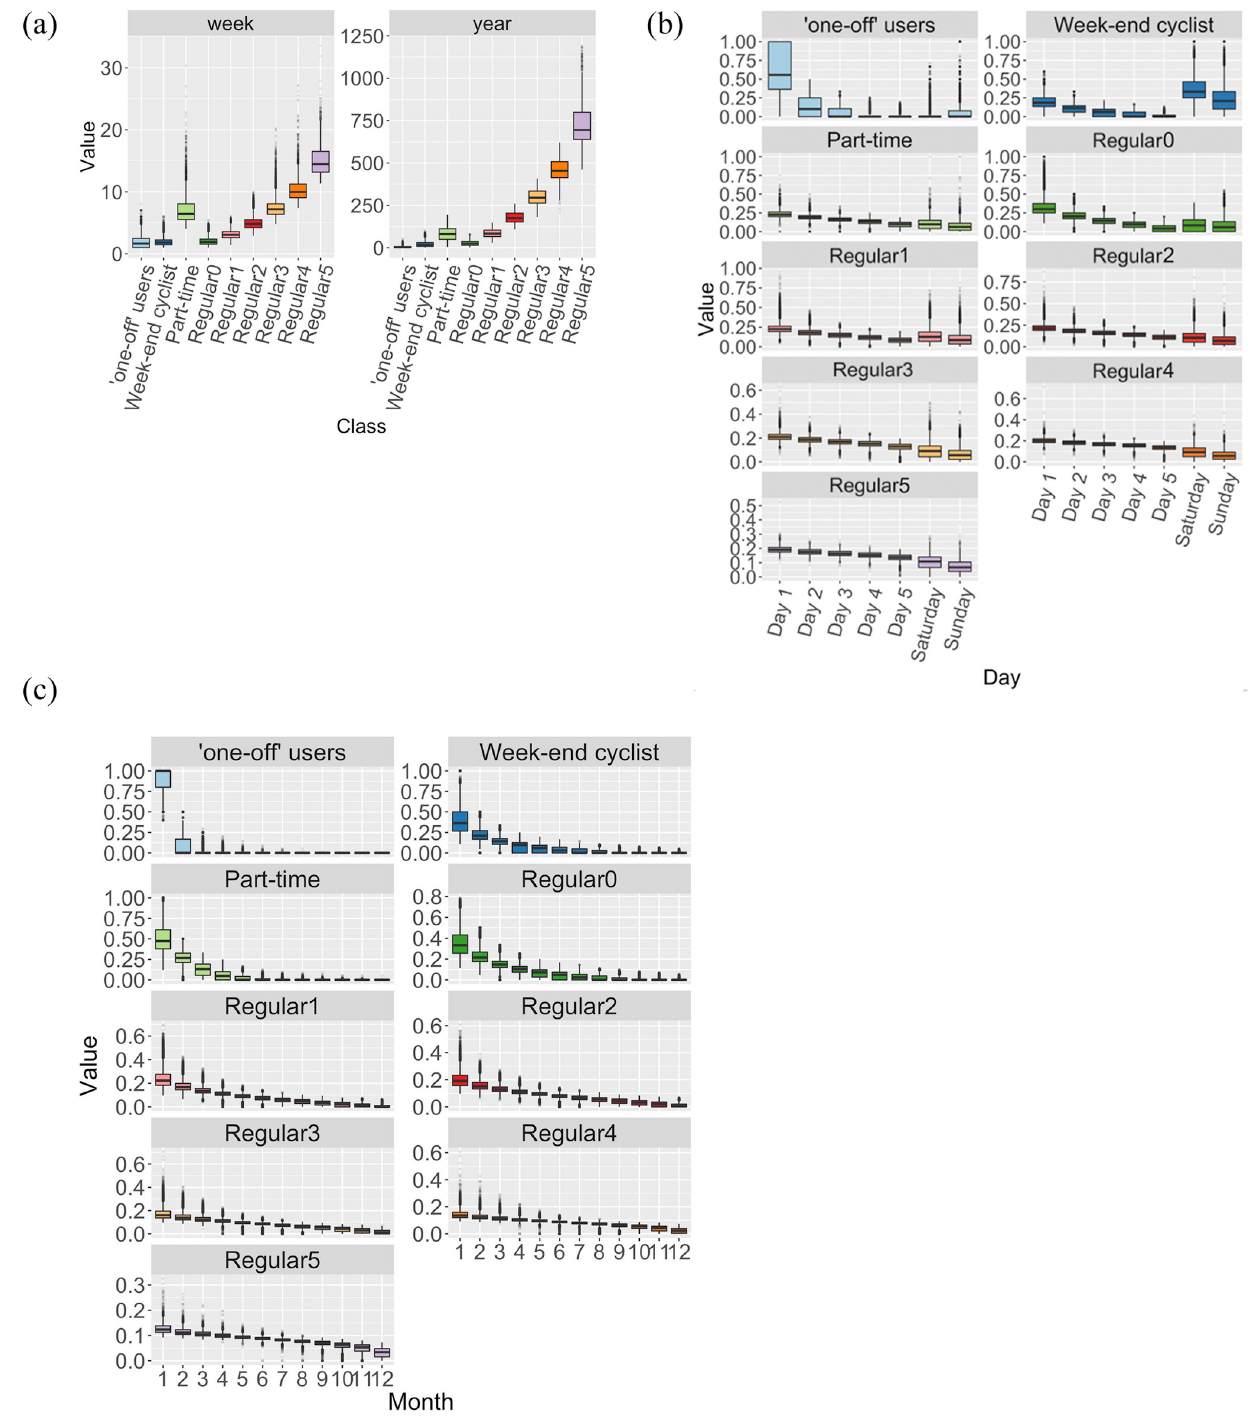
Fig 5. Boxplots of the behavioral patterns at different time scales of the 9 classes. (a) The “value” represents the number of trips per year (right) and per active week (left), for each class. A week is considered ‘active’ for a user whenever he/she takes a bicycle at least once. (b) The “value” represents the normalized number of uses for each day of the week and for each class. Week days range from one to five in decreasing order of activity for each user. Saturday and Sunday are computed separately as users’ activity is different on week-ends. (c) The “value” represents the normalized number of uses for each month of the year and for each class.